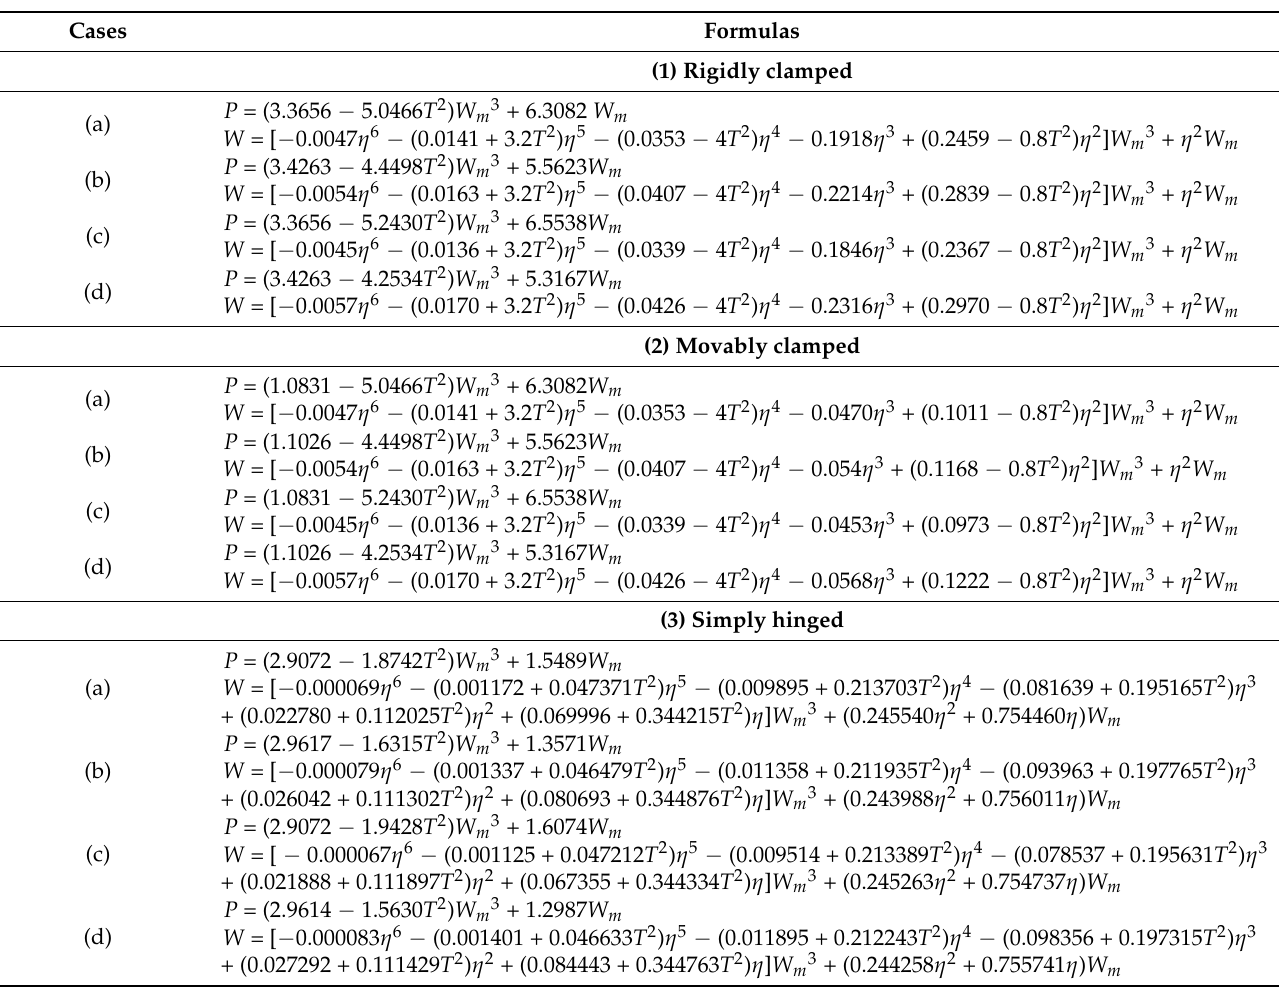
Table 2. P and W with respect to W m